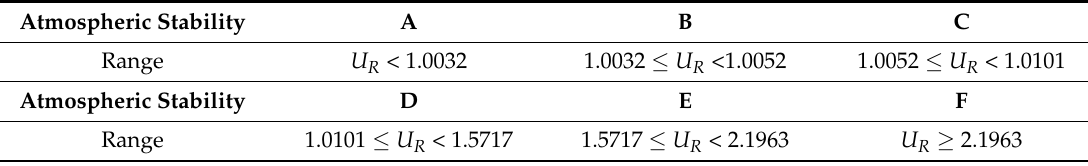
Table 3. Relationship between U R and the atmospheric